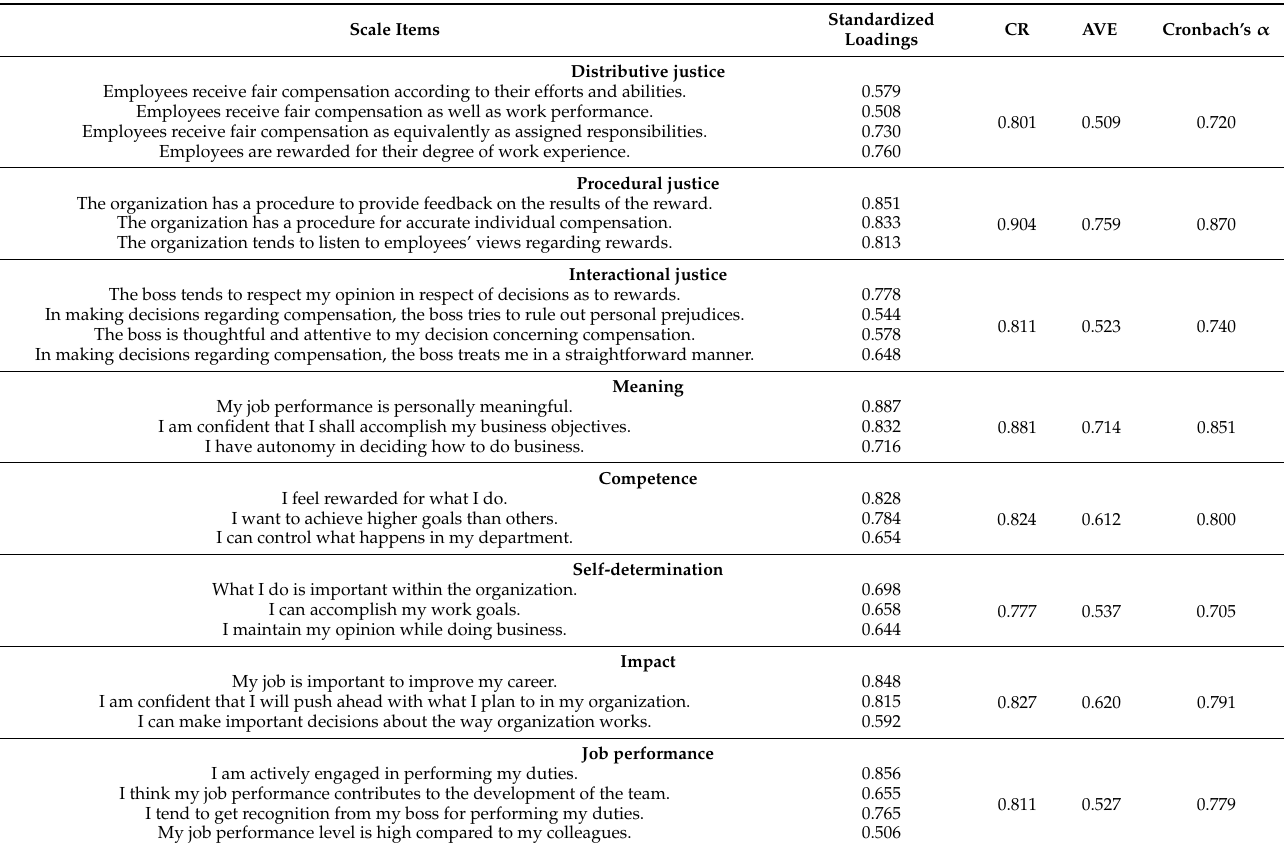
Table 1. Summarized results for the validity and reliability assessments.